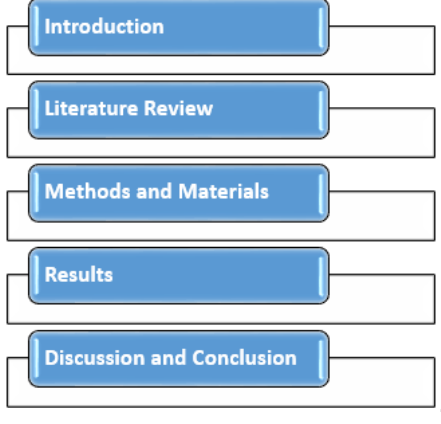
Figure 4. Structure of the paper. Table 2 shows the list of abbreviations. Table 2. List of abbreviations.